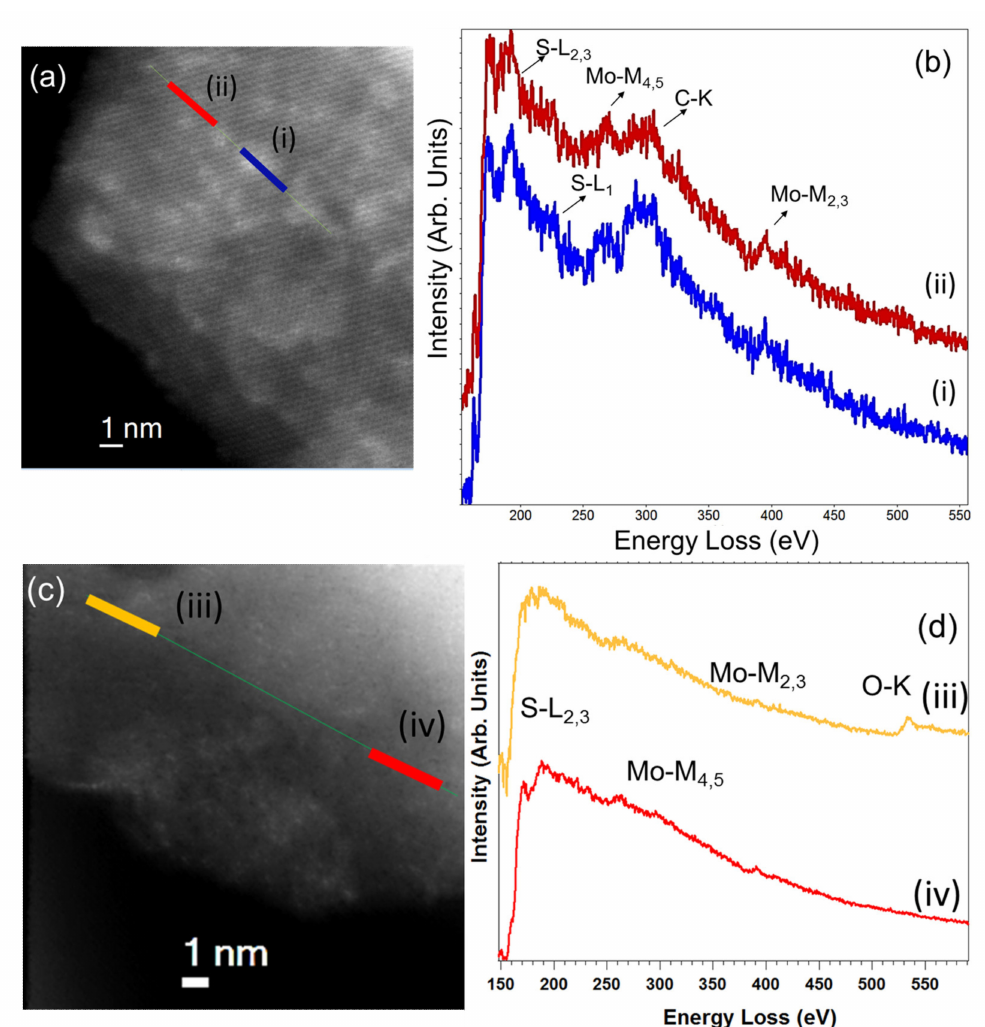
Figure 5. ( a , c ) High-angular dark-field (HAADF)-STEM micrographs of MoS 2 / pyrene 1a and exfoliated MoS 2 flakes, respectively. Two electron energy loss spectroscopy (EELS) line spectra were recorded on these flakes, see the green lines marked in Figure 5a,c. ( b ) Two EEL spectra corresponding to the sum of seven spectra recorded in each of the two areas highlighted in red (i) and blue (ii) in Figure 5a, respectively. Carbon, corresponding to pyrene, sulfur, and molybdenum (associated to MoS 2 ) are detected in these spectra. ( d ) Two EEL spectra corresponding to the addition of eight spectra collected in each of the two regions highlighted in orange (iii) and red (iv) in Figure 5c, respectively. The presence of oxygen denotes the clear oxidation of this MoS 2 flake, see text for